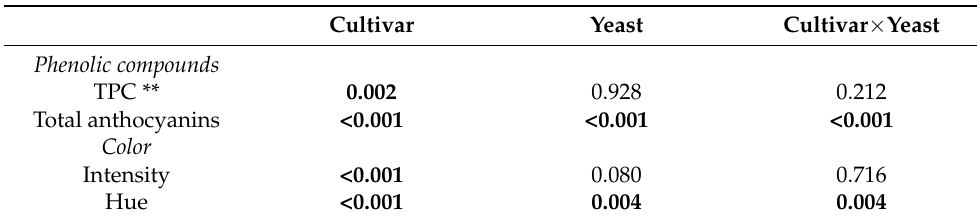
Figure 3. Contents of total anthocyanins and total phenolic compounds (TPC) ( A ) and color parameters ( B ) of the pomegranate wines from the four cultivar × yeast combinations tested. Data are averages ± standard deviations of three replicates per combination. Table 4. Results of two-way analysis of variance on phenolic compounds and color of pomegranate wines ( p -values